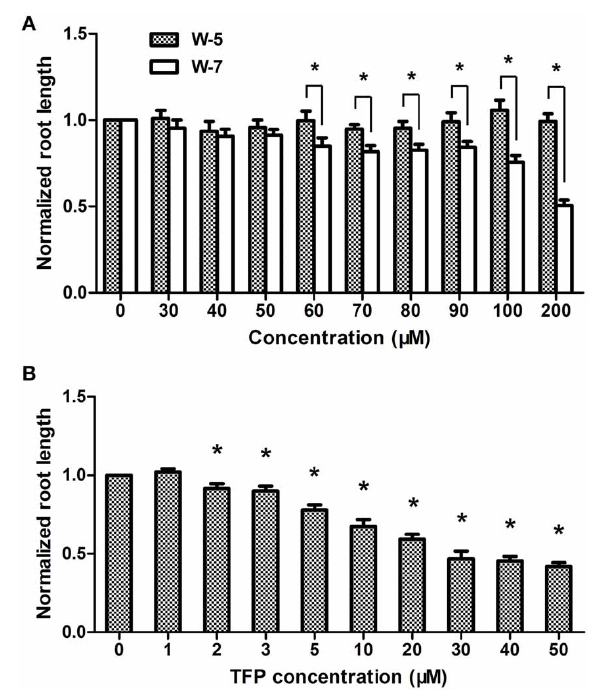
FIGURE 2 | Effects of CaM antagonist W-7 and TFP at different concentration on primary root elongation. Wild-type plants were grown on vertically oriented plates containing indicated concentration of W-7, W-5 (no-activity analog of W-7) or TFP and the primary root length was measured after 7 days of cultivation. (A) Plot of a dose-response evaluation of W-7 and W-5 (30–200 μ M) on primary root length. (B) Plot of effects of indicated concentration of TFP (1–50 μ M) on primary root length. The results were normalized to the root lengths of untreated samples. Data shown are the average of three independent experiments. Each experiment included at least 30 seedlings. Entries with p -values < 0.05 shown with asterisk.